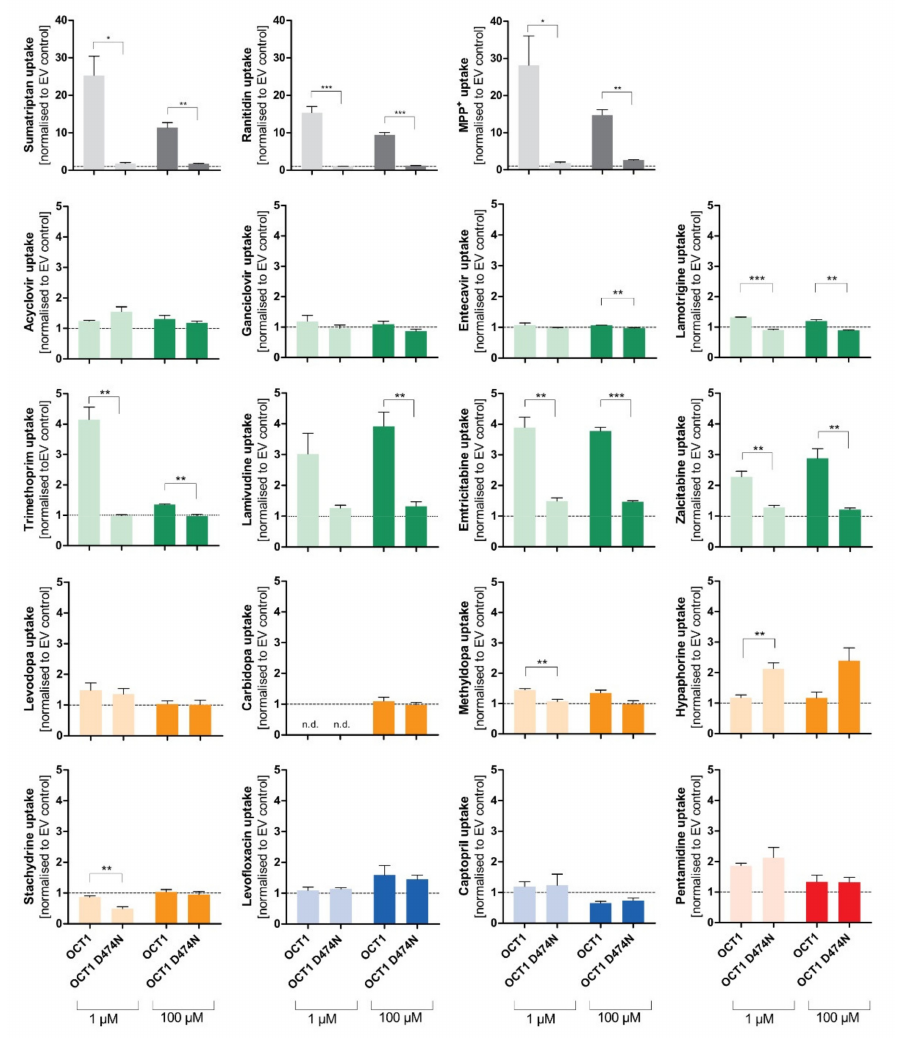
Figure 5. Effect of the D474N variant on transport of typical and atypical substrates of OCT1. HEK293 cells that were transfected stably with the OCT1 transporter, as well as cells overexpressing the variant OCT1 D474N (aspartate474-to-asparagin), were incubated with 1 µ M (light colour) and 100 µ M (dark colour) of each substance for their substrate-specific incubation time (Table 1). The substrates are grouped based on their overall charge which is indicated by the characteristic colour. The abbreviation “n.d.” indicates that the intracellular substrate concentration was below limit of quantification (not detected). The uptake by OCT1 and its variant were normalised to the uptake by the empty vector, and zero net uptake is indicated with a dotted line. The experiments were conducted at least three times (n ≥ 3) independently from each other for every substance. Statistical significance between OCT1 and OCT1 D474N was determined using an unpaired students t -test with * p < 0.05, ** p < 0.01, and *** p <